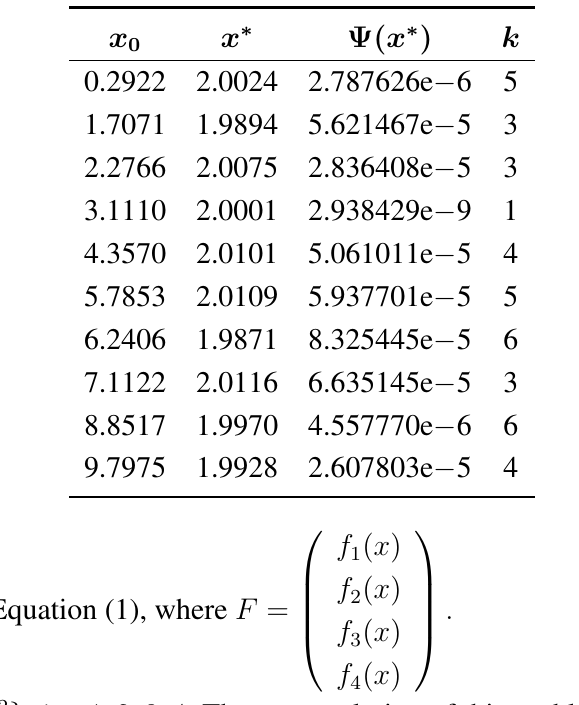
Table 5. Number of iterations and the final value of Ψ( x ∗ ) .